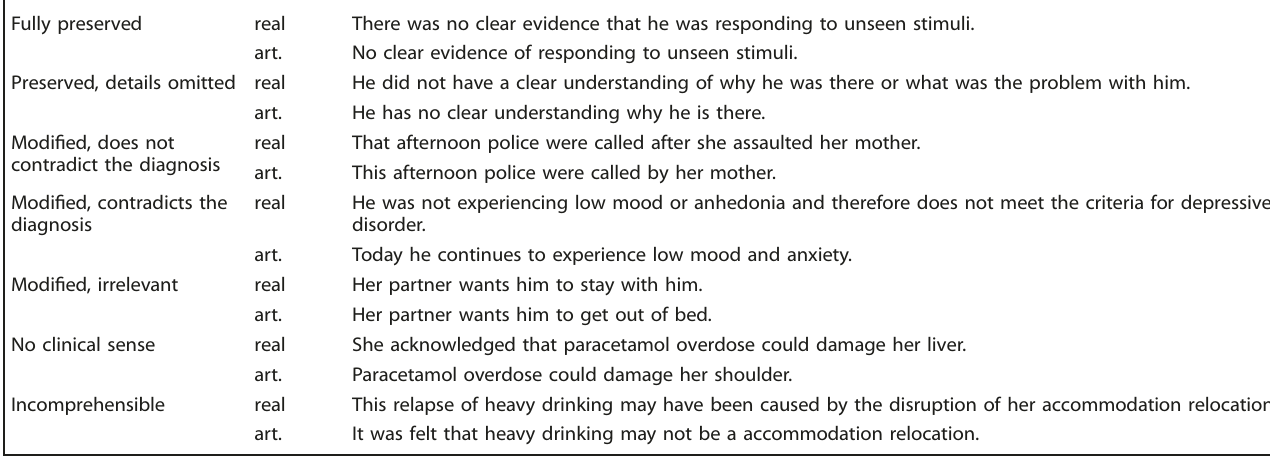
Table 5. Examples of arti fi cial sentences and respective real sentences (all paraphrased) for test-class-mhr . Fully preserved